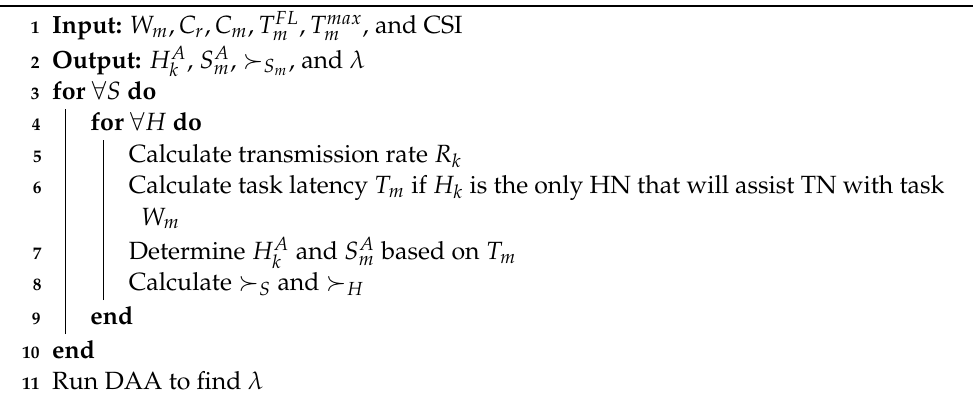
Algorithm 1 Stable matching assignments without addressing the externalities